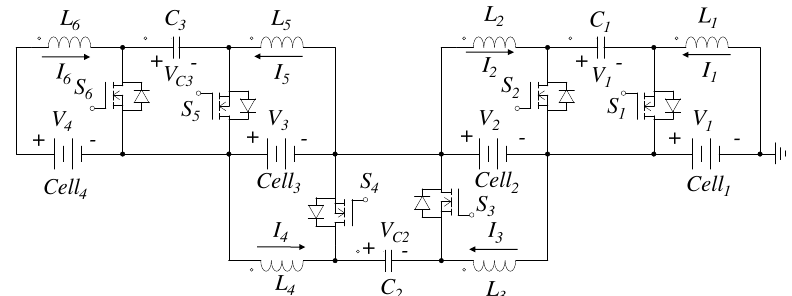
Figure 25. ´Cuk converter equalizer.